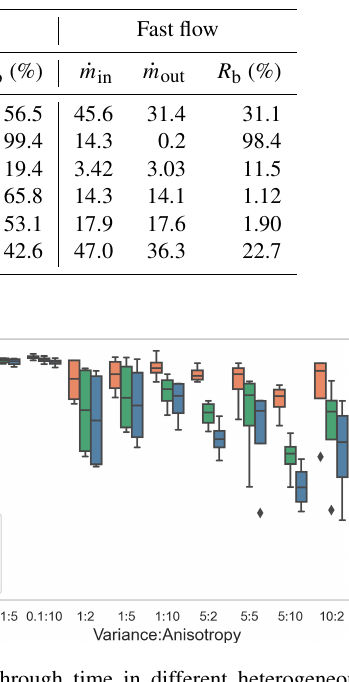
Figure 2. Breakthrough time in different heterogeneous scenar- ios (described as variance in permeability field:anisotropy) normal- ized by that in the base case (or homogeneous case) in three flow regimes: slow, medium, and fast